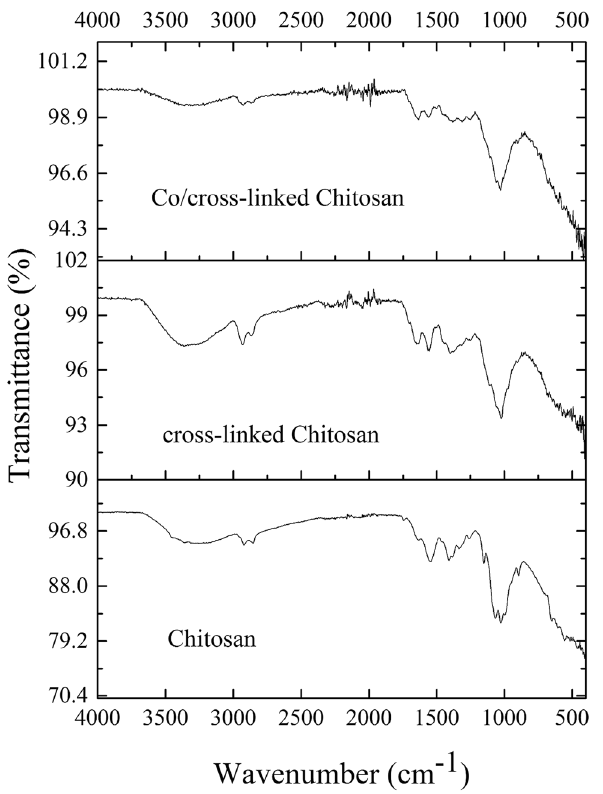
Fig. 5 FTIR spectra’s of chitosan, cross-linked chitosan and Co/cross- linked chitosan